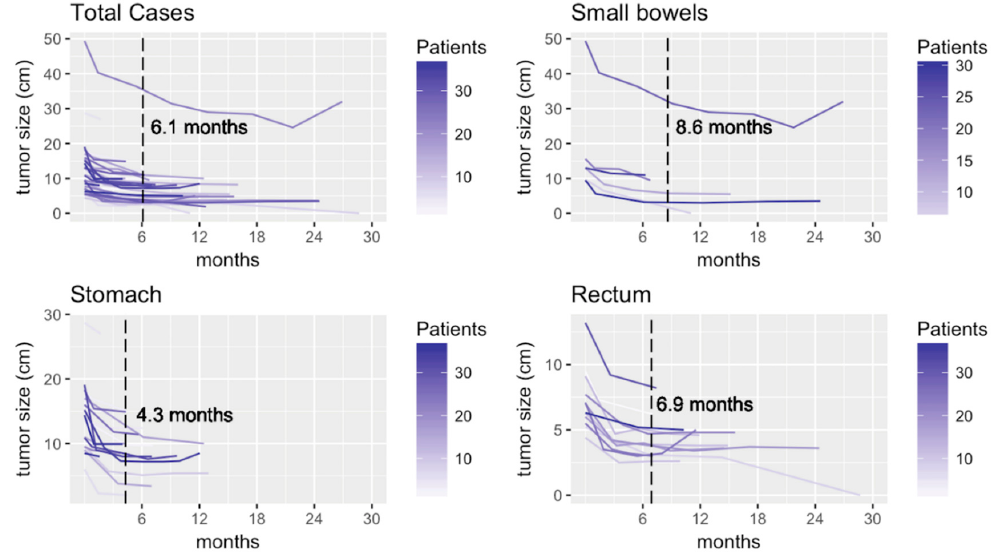
Figure 2. Change of tumor sizes of the per protocol cohort ( upper left ) and different locations of tumors: ( lower left ) for stomach; ( upper right ) for small bowels; and ( lower right ) for rectum.